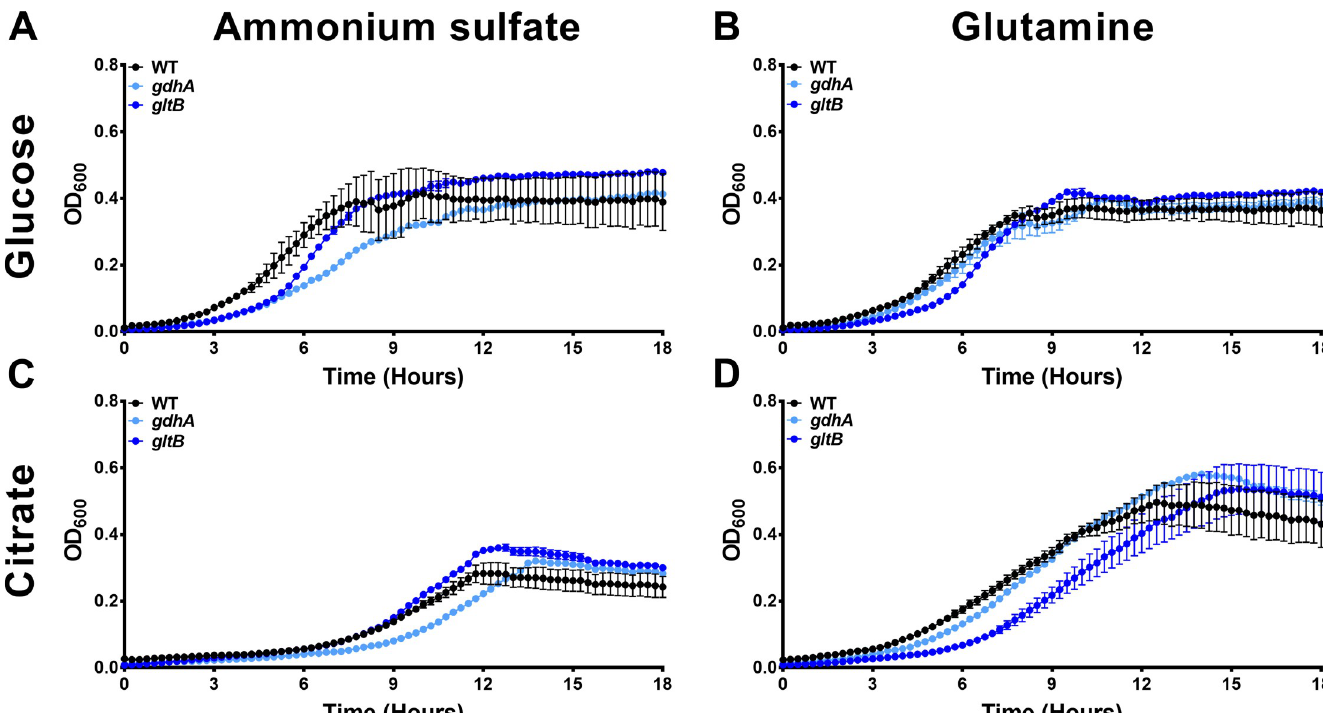
Fig 10. Different nitrogen assimilation pathways are required for optimal growth when carbon and nitrogen source are varied. Growth of wild-type P. mirabilis and isogenic mutants gltB and gdhA was measured by optical density at 600 nm every 15 min over the course of 18 hours during incubation at 37˚C with shaking in either PMSM with glucose (A, B) or citrate (C, D) as the carbon source. Growth medium was supplemented 0.2% ammonium sulfate (A, C), or 0.2% ammonium sulfate with 0.2% glutamine (B, D). Error bars represent the mean ± standard deviation from three independent experiments, three replicates each.